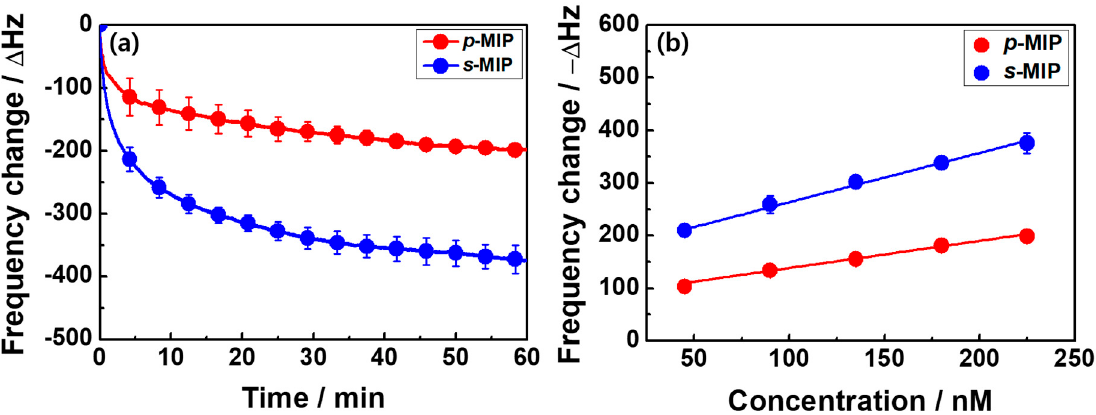
Figure 2. ( a ) Frequency change ( f ) as a function of time on the surface of two MIP films ( p ‐ MIP and s -MIP) in a 225 nM BPA aqueous solution for a 1-h rebinding process (n = 3) and ( b ) − ∆ f values on the p -MIP and s -MIP films as a function of the initial BPA concentration (C 0 , 45–225 nM) for a 1-h rebinding process.